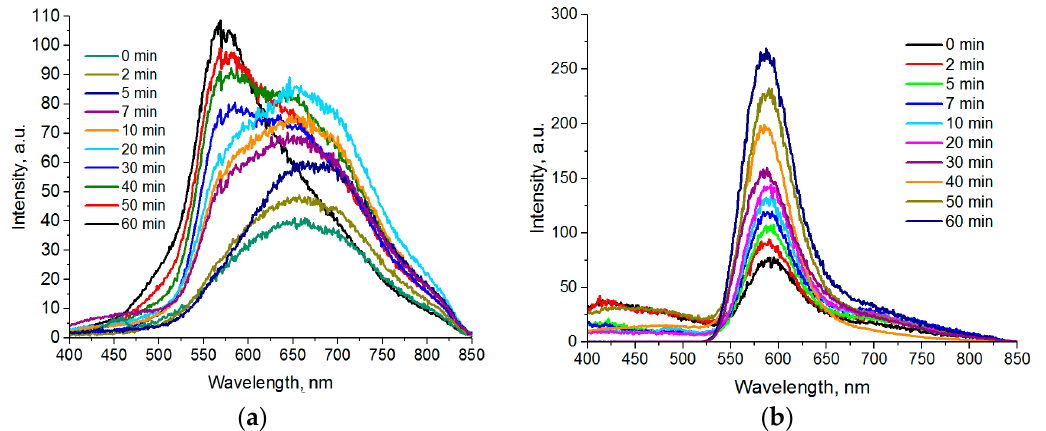
Figure 4. Luminescence spectra of QDs taken at various times after the start of synthesis: ( a ) Cd 0.9 Mn 0.1 S; ( b ) Zn 0.9 Mn 0.1 S.